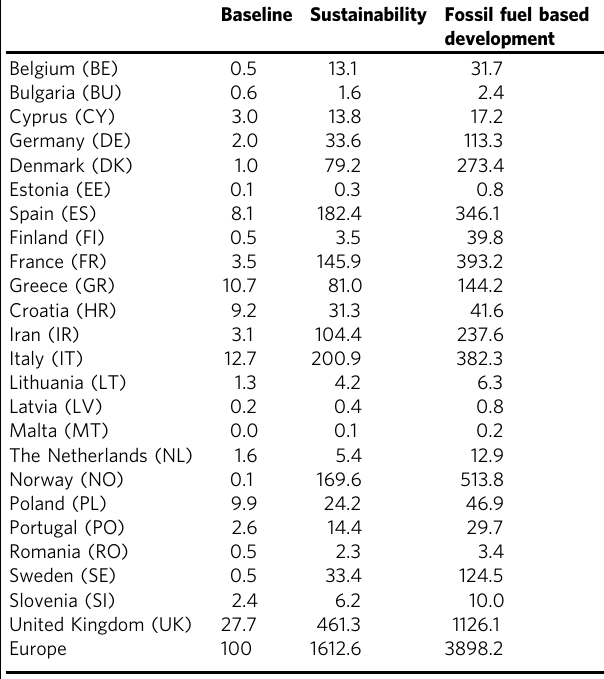
Table 1 Direct damages without any future adaptation measures.